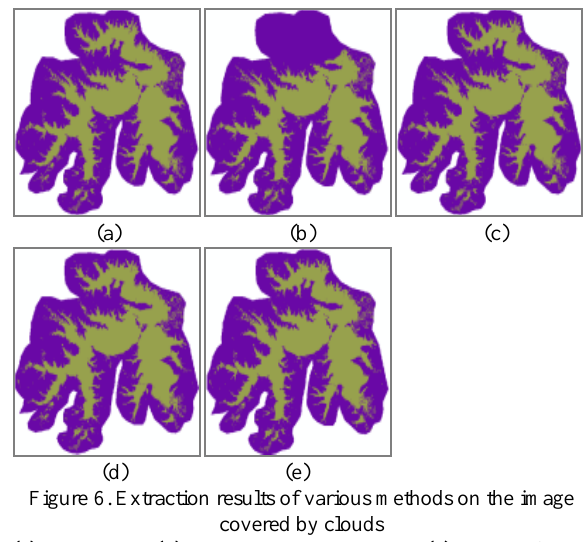
Figure 6. Extraction results of various methods on the image covered by clouds (a) True image (b) Image covered by clouds (c) Result of PSM (d) Result of LHM (e) Result of GHM